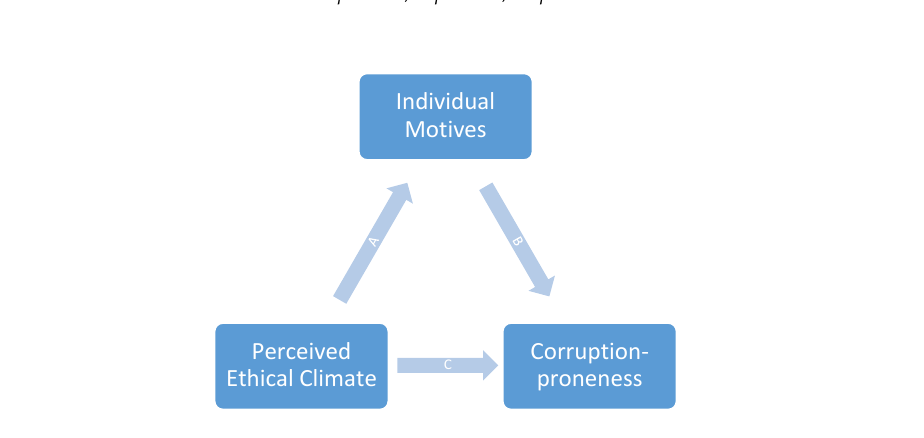
Figure 1. Model of individual motives as mediators of the ethical climate–corruption relationship.